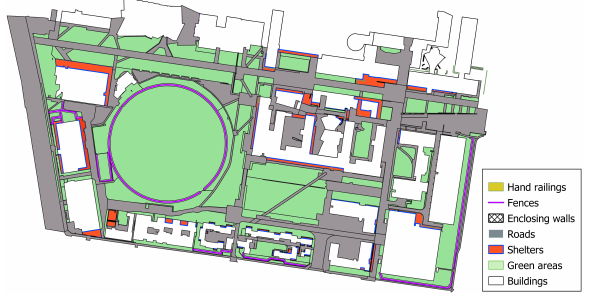
Figure 10. The navigation network automatically derived from 3D spaces based on Poincar´e duality.